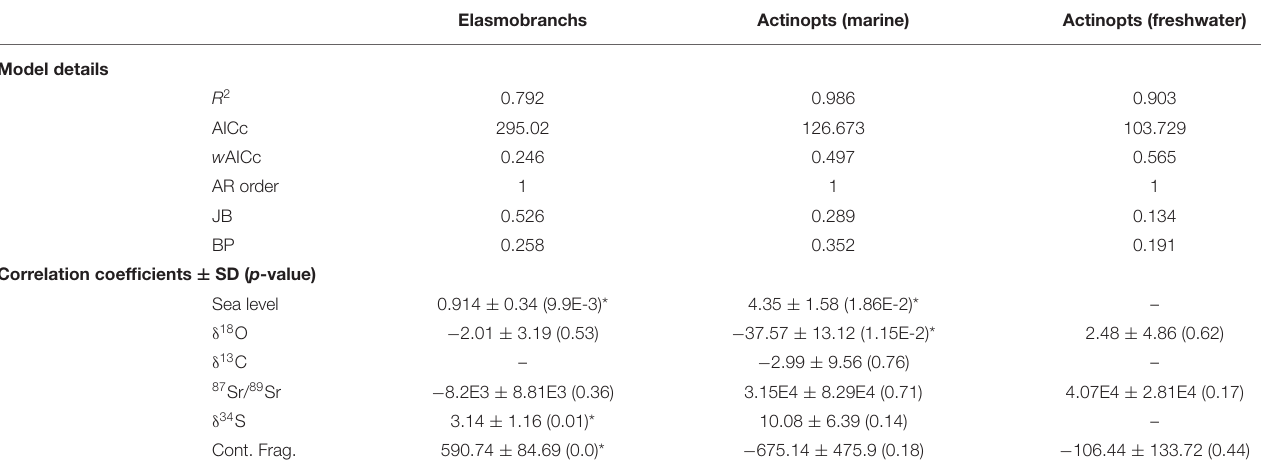
Elasmobranchs Actinopts